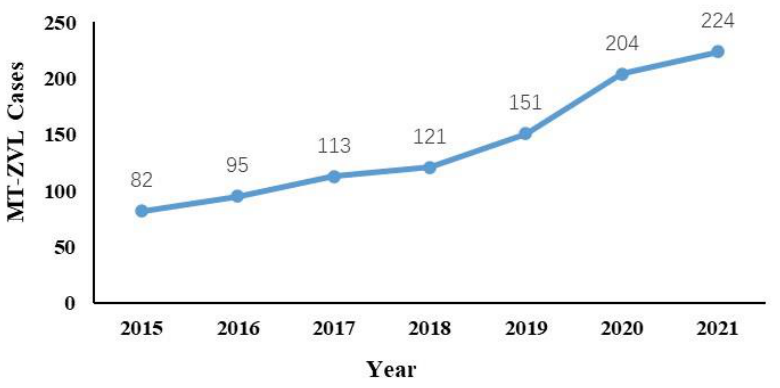
Figure 1. Changes in number of patients with mountain-type zoonotic visceral leishmaniasis in China from 2015 to 2021.